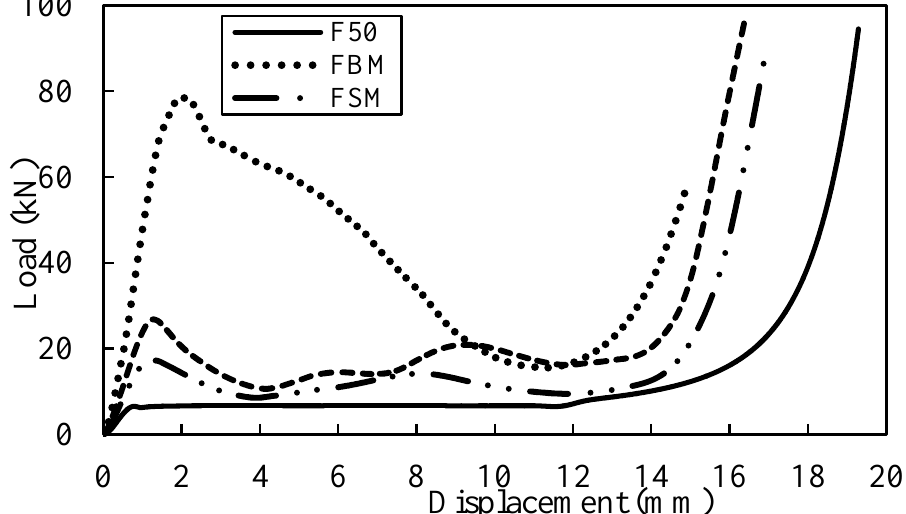
Figure 10. Load-displacement curve for multiple tube reinforced with F50 foam structure.